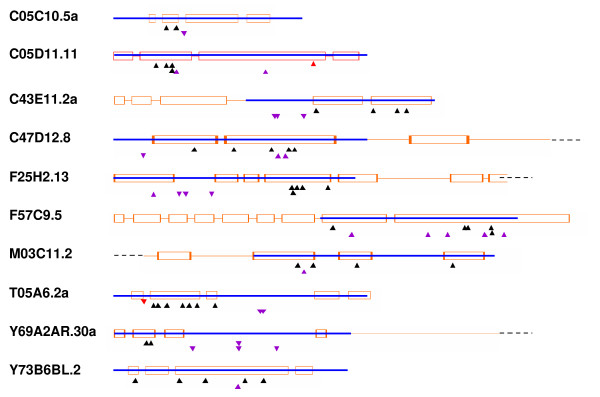
Gene models depicting the distribution of different types of mutations within the genes. The figure was designed from PARSESNP [42] output files. Blue lines indicate the extent of the amplified region that was used for TILLING. Orange open boxes denote exons. Purple up arrows indicate a change in the DNA sequence that does not affect the amino acid product. Purple down arrows indicate a change in non-coding DNA. Black up arrows indicate a change that induces a missense mutation in the predicted protein product. Red up arrows indicate a premature stop codon or splice junction error.